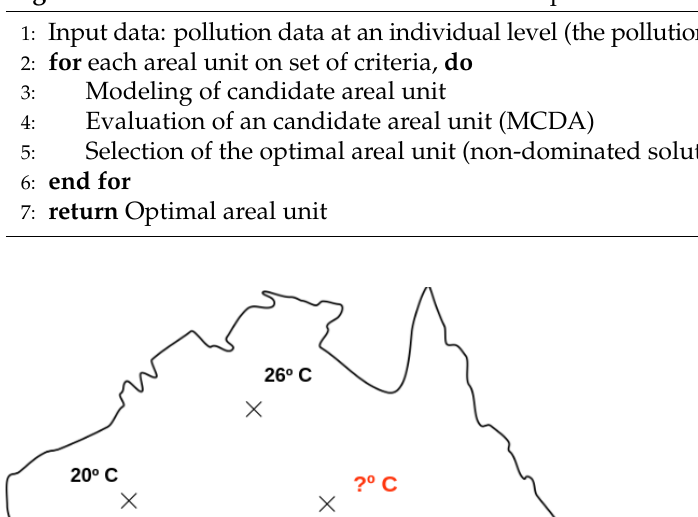
Algorithm 1 Multicriteria for the selection of an optimal areal unit